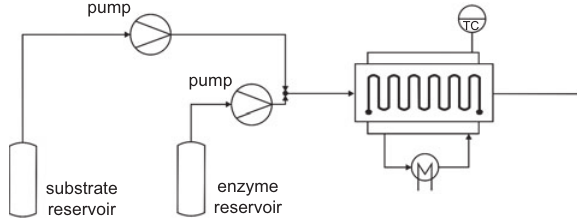
Figure 3 Set-up for the analysis of the enzymatic reaction.